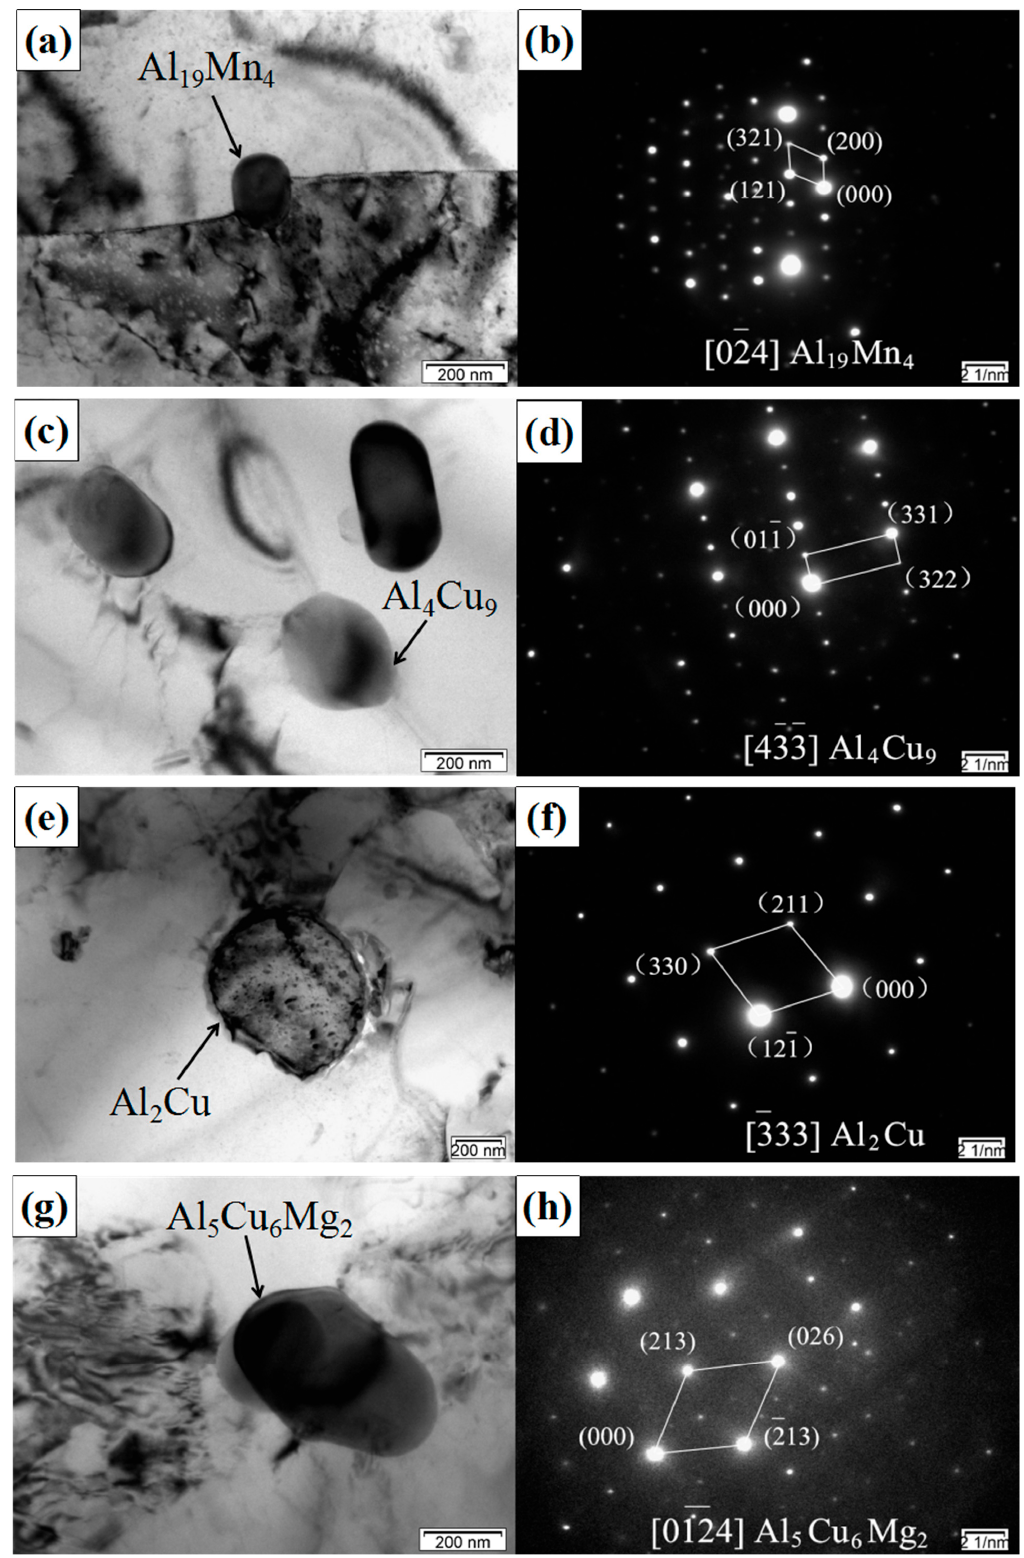
Figure 5. TEM images of SiCp/Al-Si composites without CeO 2 : ( a ) the precipitated phase Al 19 Mn 4 ; ( b ) diffraction patterns of Al 19 Mn 4 ; ( c ) the precipitated phase Al 4 Cu 9 ; ( d ) diffraction patterns of Al 4 Cu 9 ; ( e ) the precipitated phase Al 2 Cu; ( f ) diffraction patterns of Al 2 Cu; ( g ) the precipitated phase Al 5 Cu 6 Mg 2 ; ( h ) diffraction patterns of Al 5 Cu 6 Mg 2 .